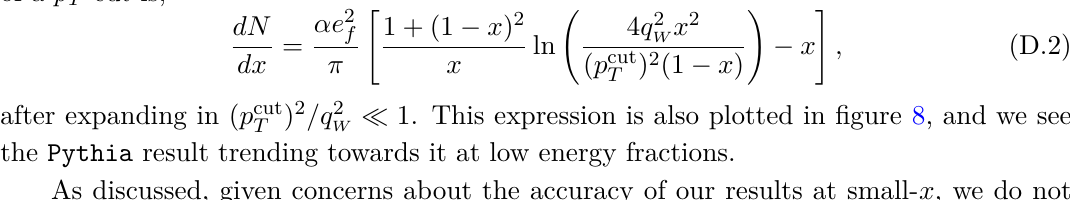
= 1 keV. The T spectrum motivated an alternative T